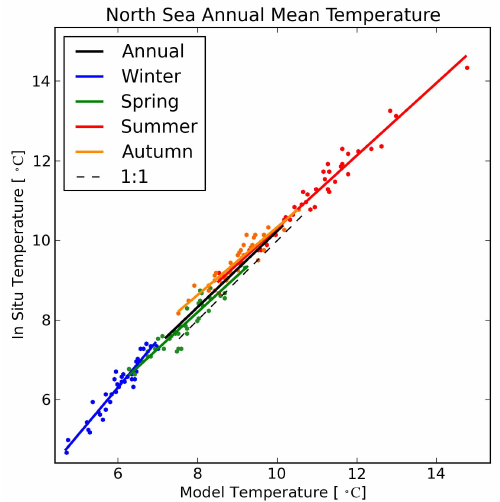
Fig. 3. Two-dimensional scatter plot of annual mean matched model data against in situ measurements for the North Sea temperature. The solid coloured lines show the linear regression fits for the an- nual and seasonal annual means data, and the dashed line is the line of unity slope that passes through the origin. The matched seasonal means are shown as colour-coded scatter